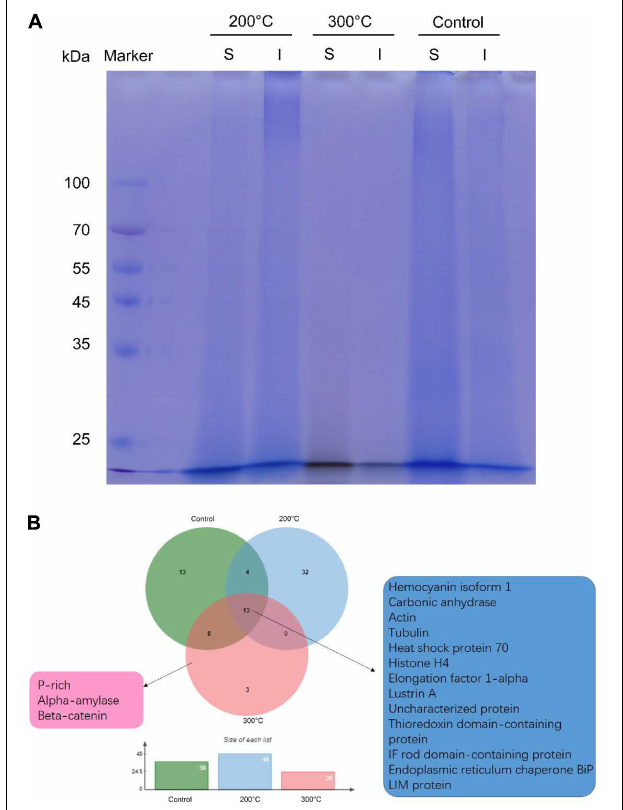
FIGURE 3 | Proteomic analysis of shell matrix proteins from the toasted shell. (A) SDS-PAGE of EDTA-soluble matrix and EDTA-insoluble matrix of toasted shells at 200, 300 ◦ C and the native shell (as the control). S: EDTA-soluble matrix; I: EDTA-insoluble matrix. (B) Venn diagram of identified proteins in the three groups by